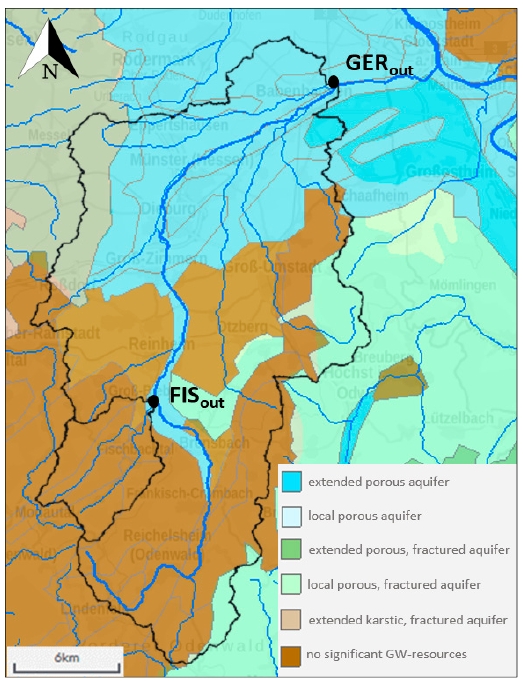
Figure 3. Groundwater resources in the GER and FIS (data source: BfG [38]).